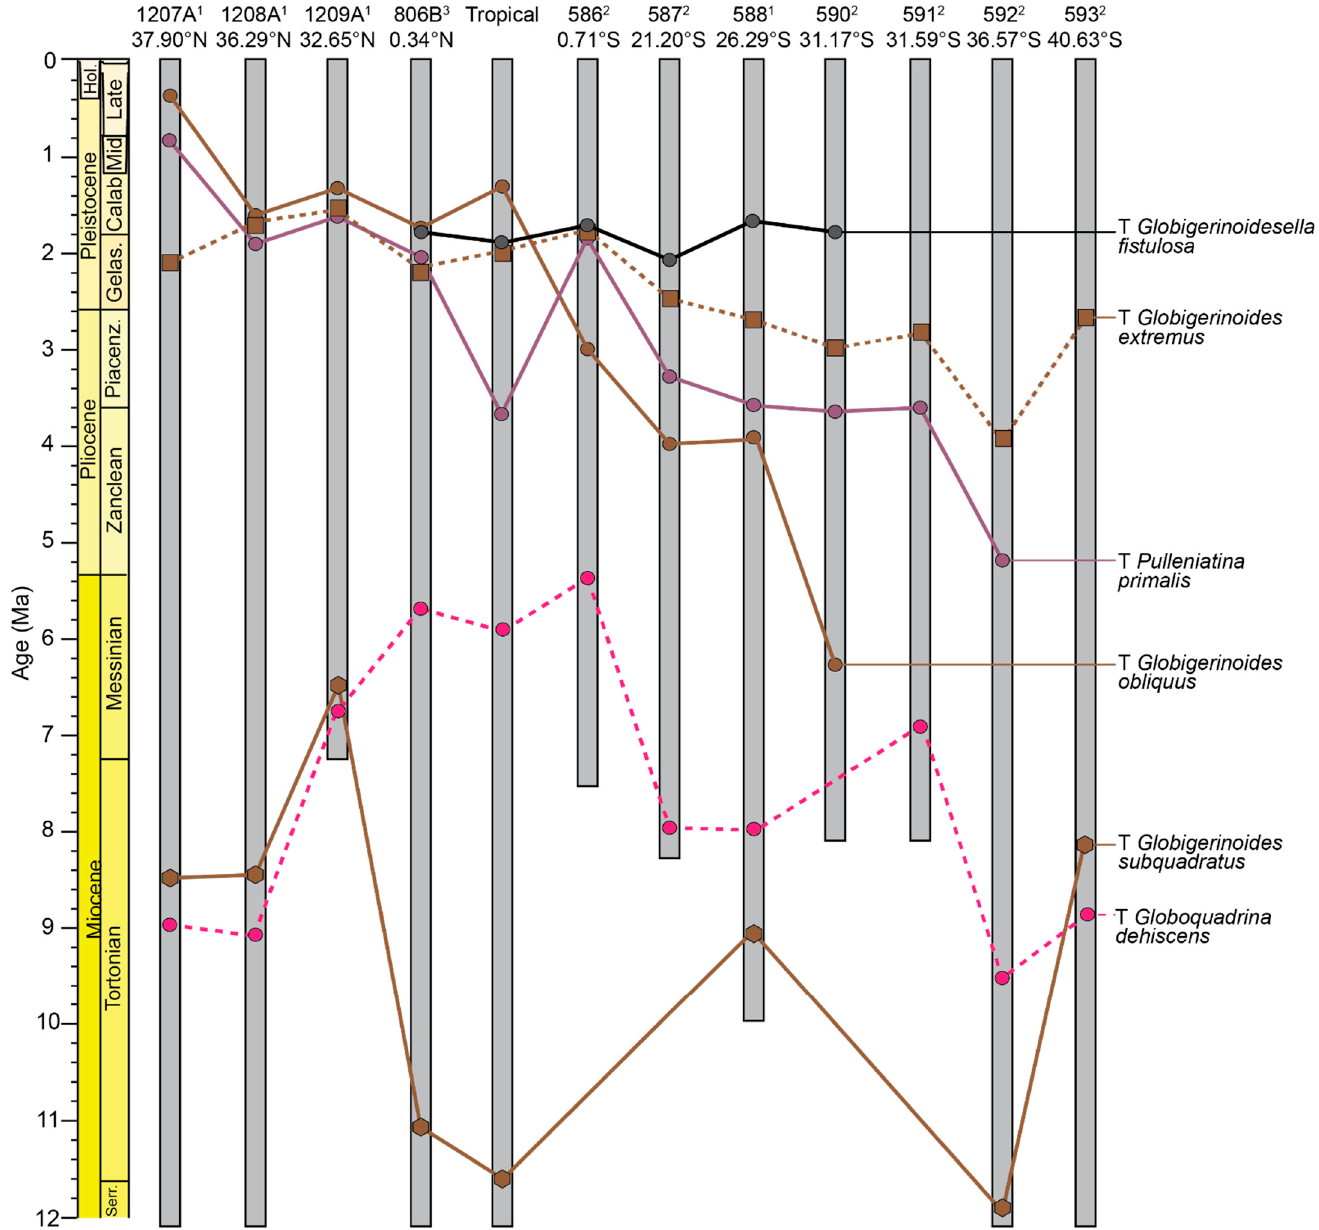
Figure 4. Last occurrences of species used as primary and secondary datums in tropical-to-mid-latitude biostratigraphic zonations belonging to the genera Globigerinoides , Globigerinoidesella , Pulleniatina , and Globoquadrina . Sites are ranked 1–3, as denoted by the superscript number beside each site number. A ranking of 1 indicates that the sites’ age model is based solely on magnetostratigraphy, a ranking of 2 indicates that the sites’ age model is a mix of magnetostratigraphy and biostratigraphy, and a ranking of 3 indicates that the sites’ age model is based solely on biostratigraphy (Supplementary Table S1).